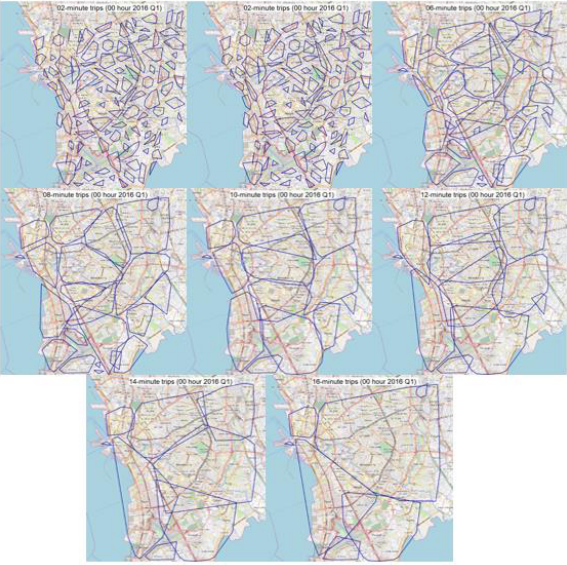
Figure 5. Clustering (indicated by blue polygons) for different time filters in 00 hour of the